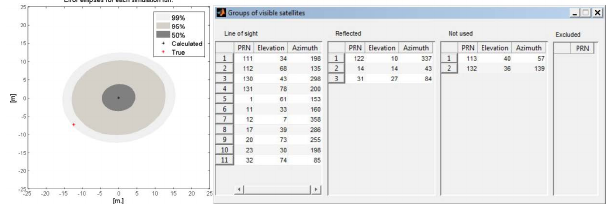
Figure 13: Illustration of position accuracy with error ellipses (left), listing of satellite information for line of sight satellites as well as for satellites reflected, blocked, and not